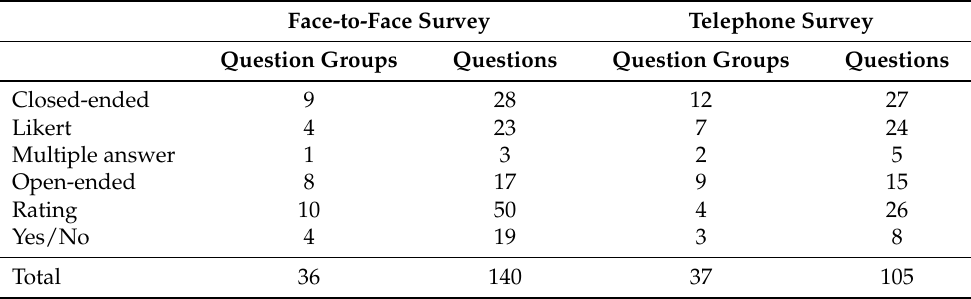
Table 1. Summary of the number of questions and question groups included in each of the surveys studied, in terms of question typology.